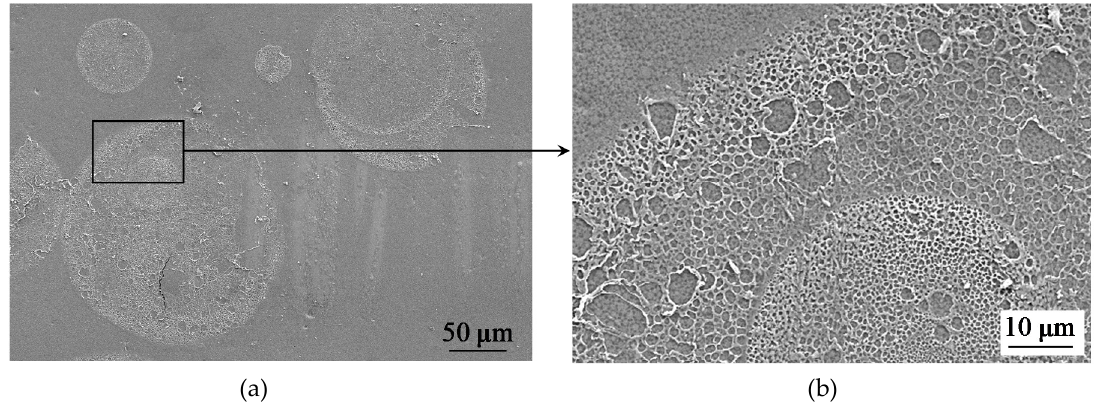
Figure 5. SEM image of the surface of the modified AMX 3 membrane; ( b ) is the magnification of the region within the black rectangle shown in ( a ).